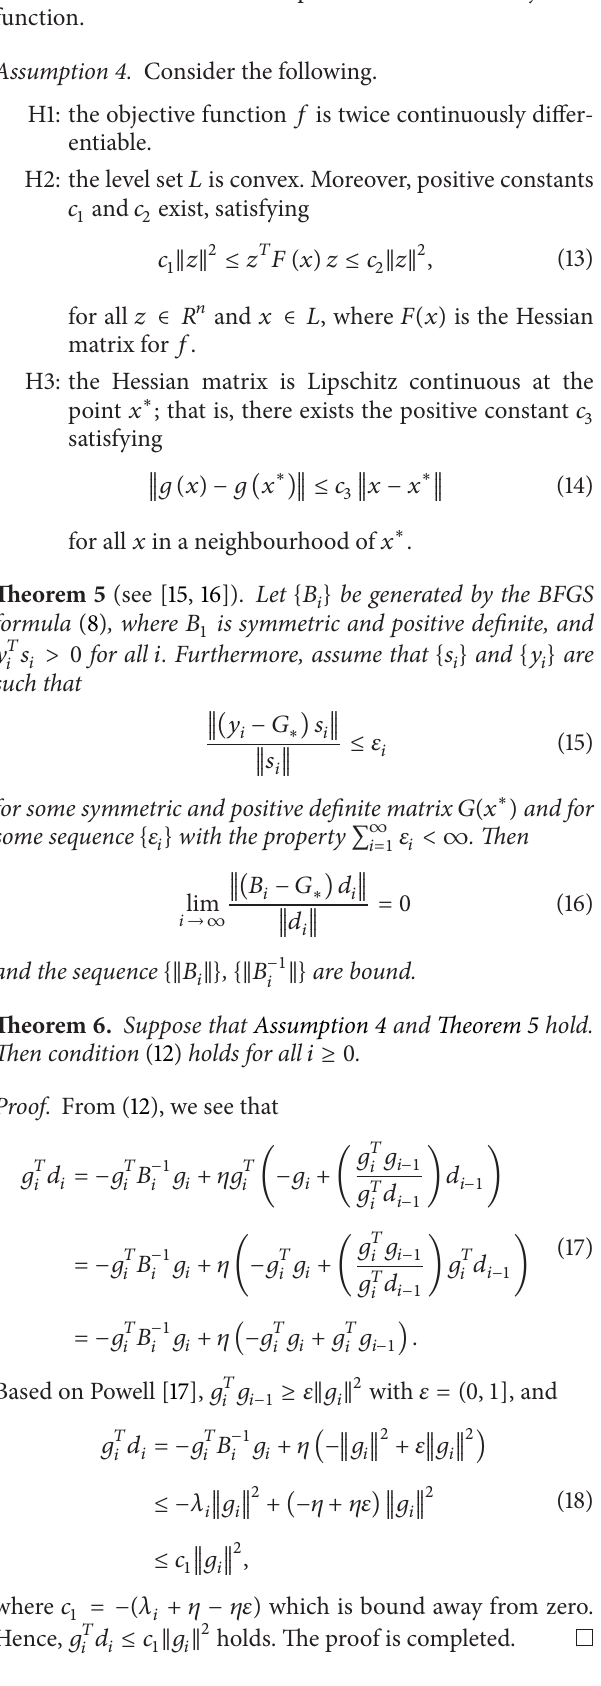
Algorithm 1 ( BFGS method ). States the following.